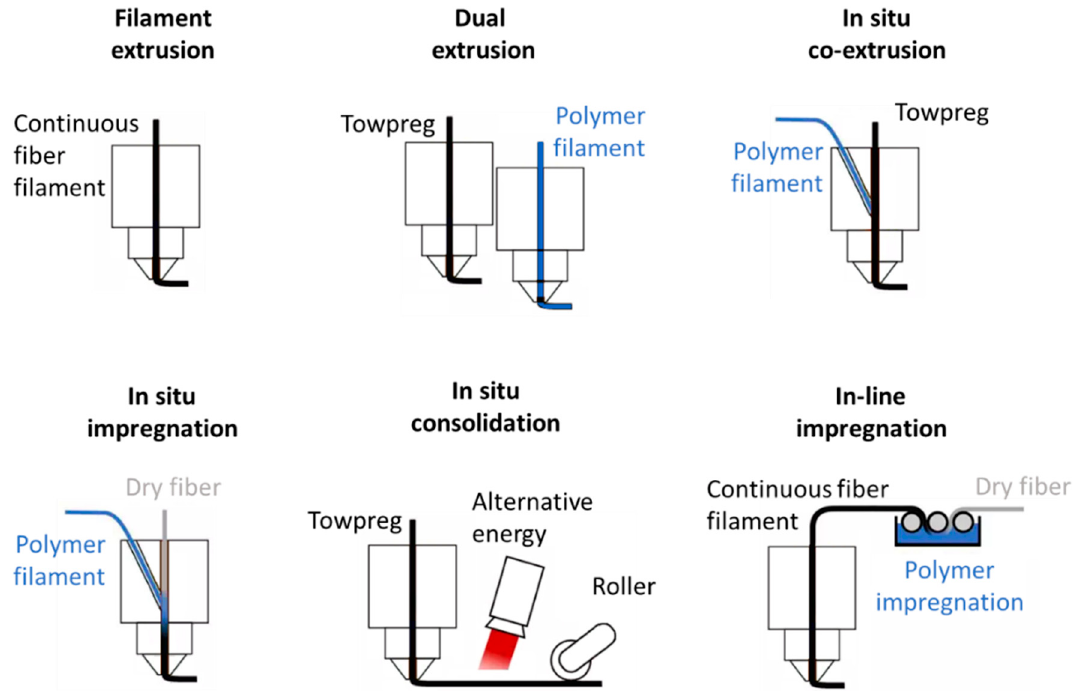
Figure 18. Main commercial of FFF processes for CFRTPC printing classified by increasing complexity, inspired by [116]. Table 1. Suppliers of commercial FFF adapted to CFRTPC printing.